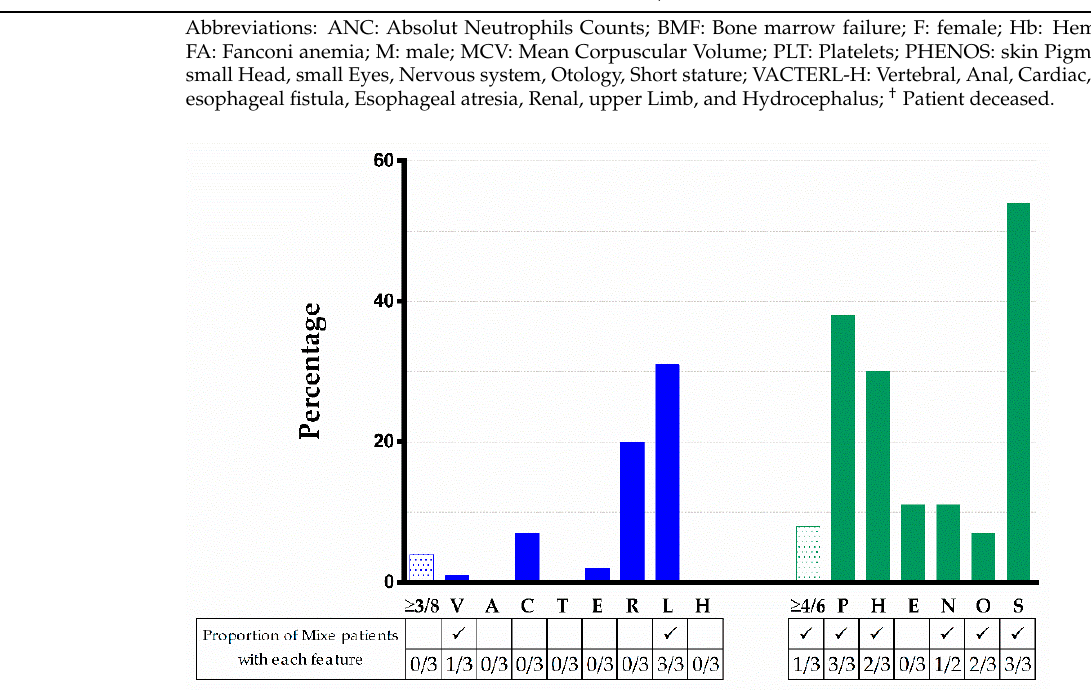
Figure 5. VACTERL-H and PHENOS features in 84 patients from the literature with a FANCG genotype and comparison with the three patients with FA here described. Upper limb includes abnormal thumb +/ − abnormal radius. Nervous system includes structural brain malformations other than hydrocephalus. Otology comprises ear malformations and/or hearing loss. Solid blue or green bars: VACTERL-H or PHENOS; dotted bars: individual findings. Horizontal axis: abnormalities analyzed; vertical axis: percent of total cases with that abnormality. VACTERL-H association ( ≥ 3/8 features) was present in 4% and PHENOS ( ≥ 4/6 features) in 8% of patients. The proportion of Mixe patients with each feature is shown in the table below the figure. The character ✓ means that this finding was found among Mixe patients. Imaging brain evaluation was performed in only two patients.